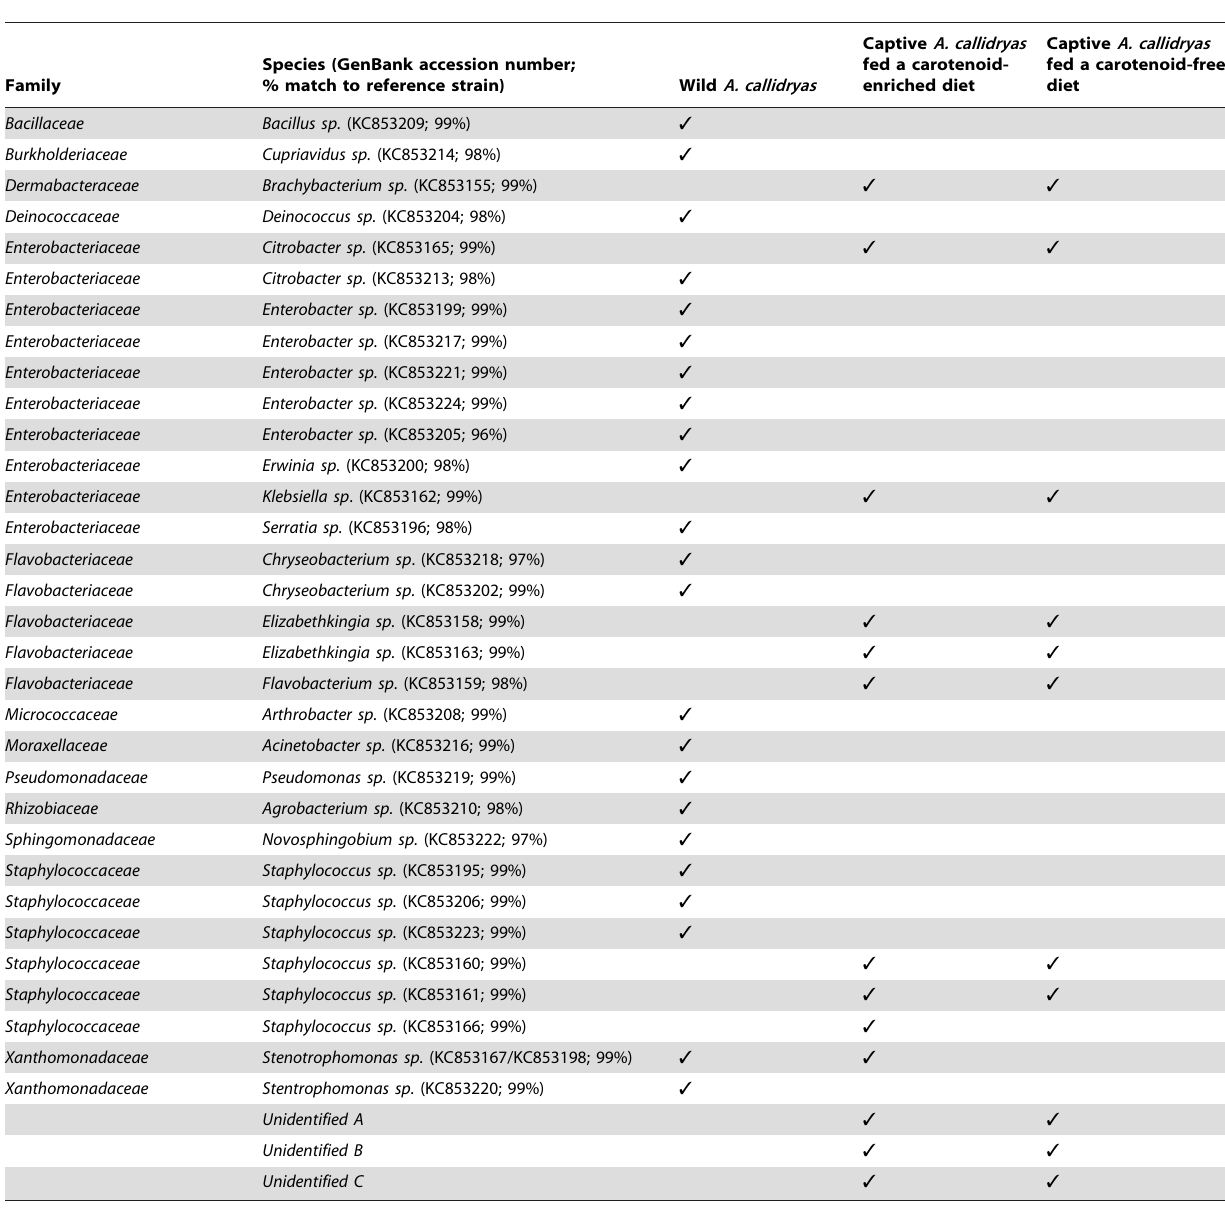
Table 1. Bacteria isolated from wild Agalychnis callidryas , and captive A. callidryas fed on a carotenoid-enriched and a carotenoid- free diet.